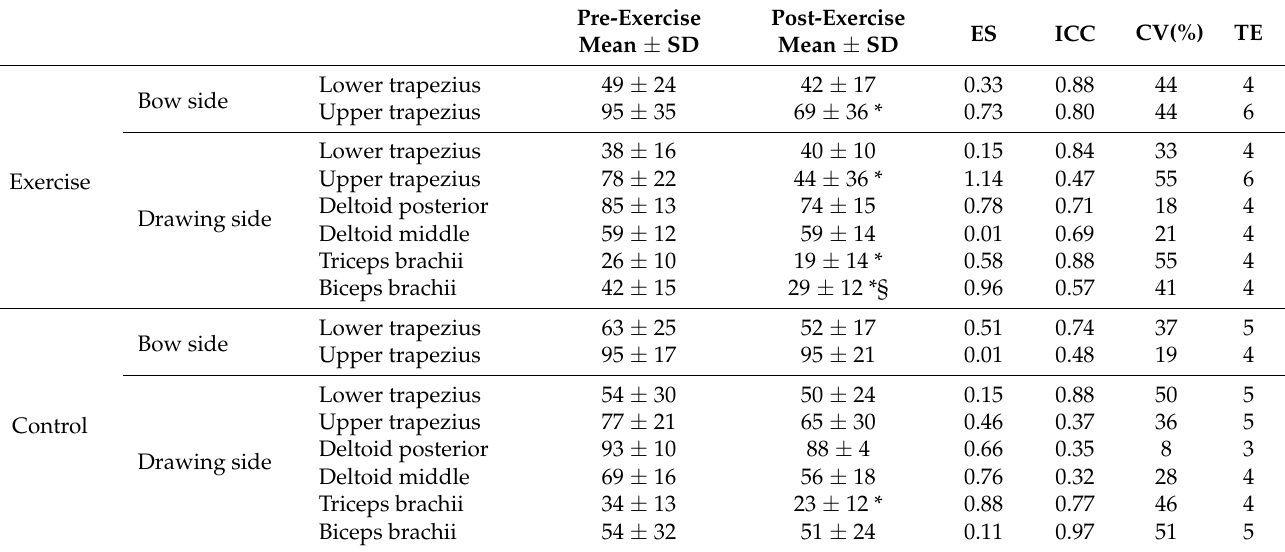
Table 2. Before releasing EMG %MVC.